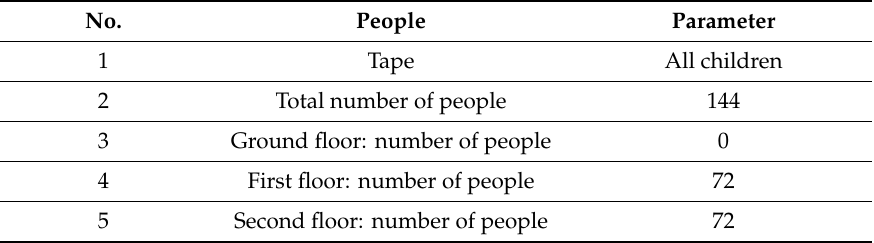
Table 3. Parameter settings for